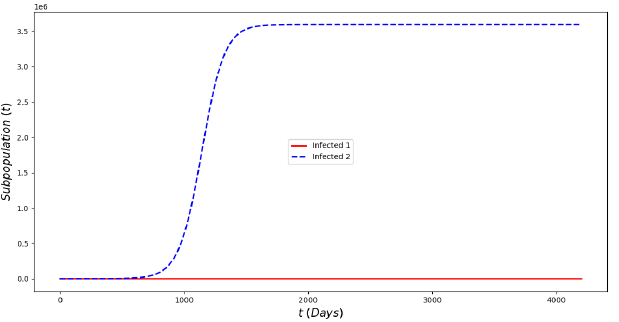
≈ 1.04 > R ≈ 0.9. The 0 1 2 1